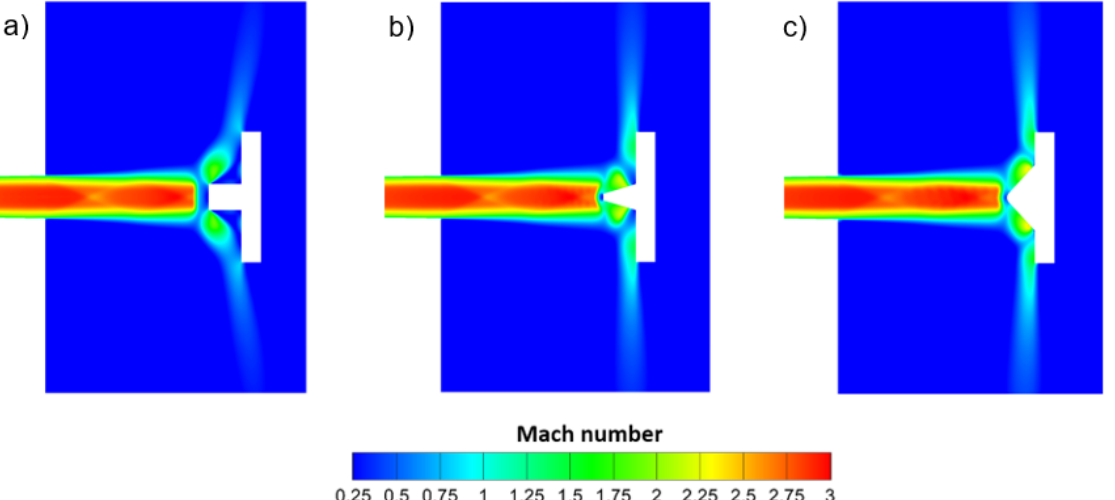
Figure 8. Mach number contour for the cases with ( a ) vertical wall, ( b ) inclined wall, and ( c ) the smooth wall.